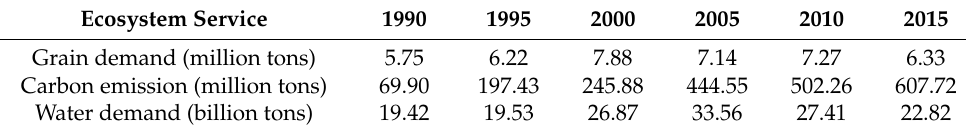
Table 5. Demand of the different ecosystem services in the Pearl River Delta from 1990 to